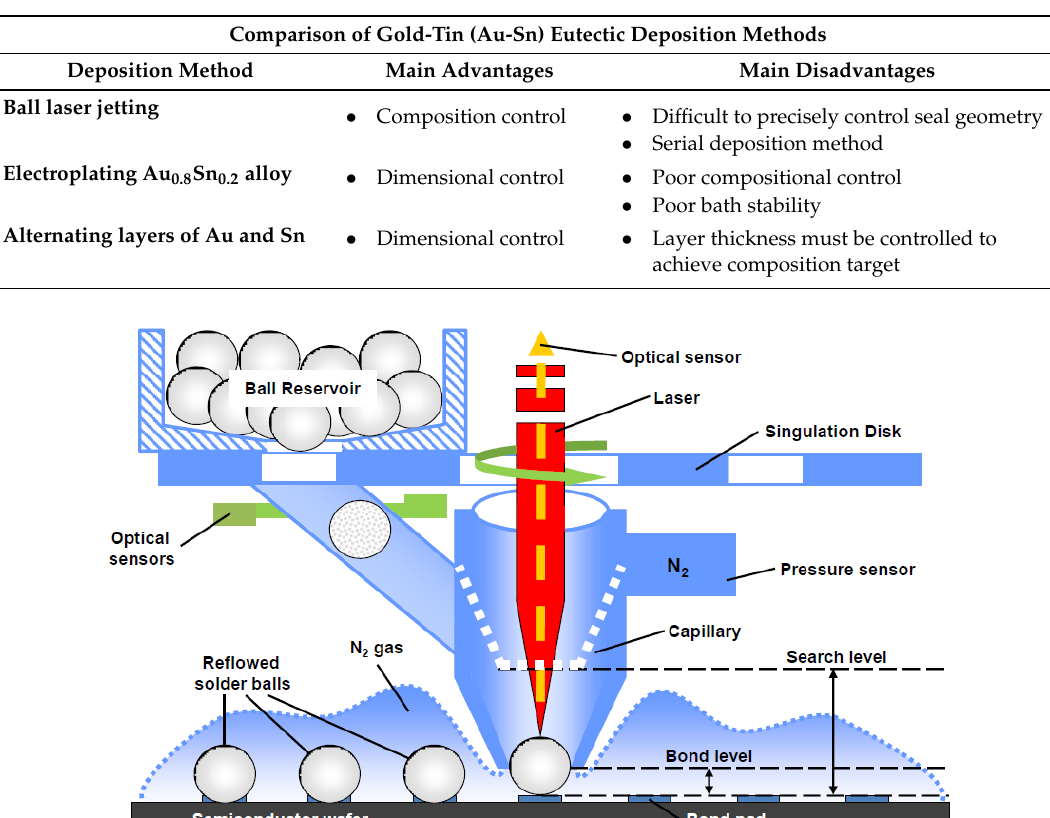
Figure 3. Diagram depicting the solder jetting process [43]. Reprinted with permission from PacTech.